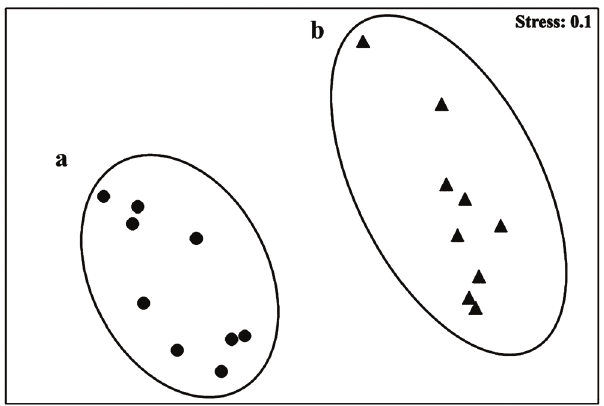
Fig. 4. Multidimensional scaling ordinations showing local differences in (a) No Tourism site and (b) Tourism site. Each individual point represents a replicate sample (census). Circles = No Tourism site; Triangles = Tourism site.